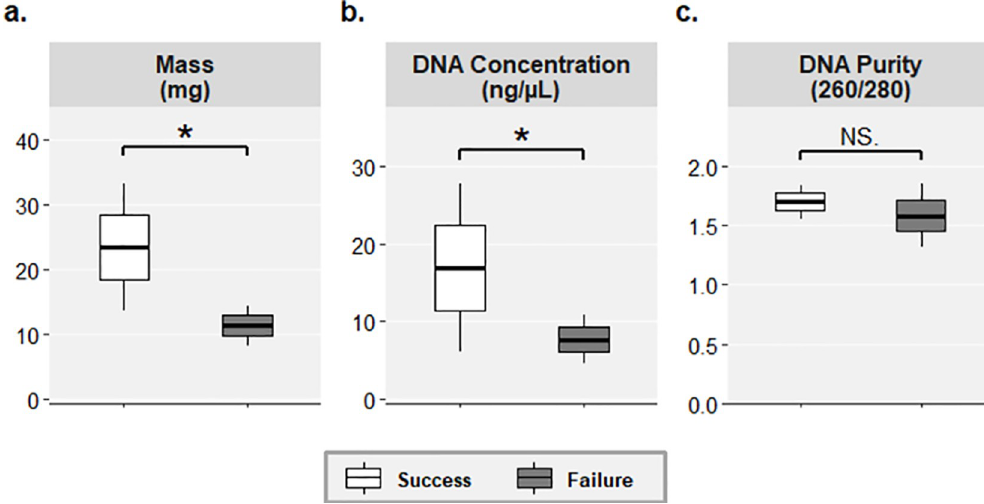
Fig 4. Differences in sample characteristics ( a. dry mass, b. DNA concentration, and c. DNA purity) between samples with sequencing success or failure. Significant correlations are indicated as follows: � p < 0.05, �� p < 0.01, NS. = not statistically